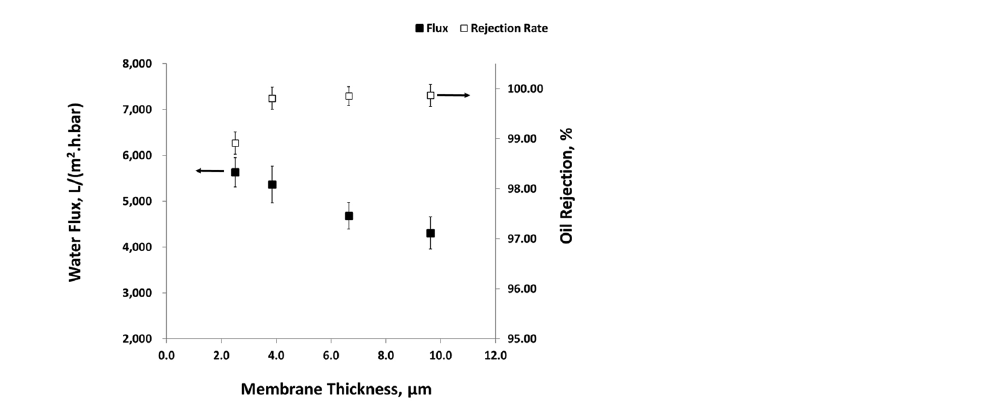
Figure 5. Permeate water flux and oil rejection ratio as a function of 3D membrane